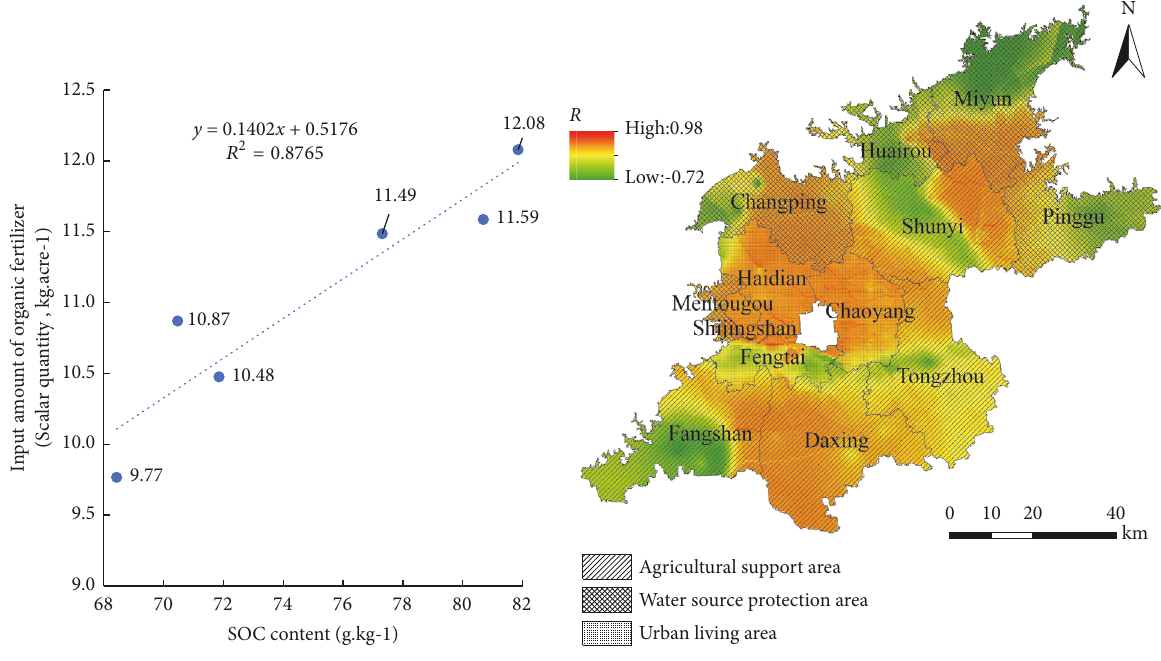
(b) Spatial correlation between soil organic carbon content and input amount of organic fertilizer Figure 4: The relationship between soil organic carbon and the input of organic fertilizer. Values in each row with the same letter are not significant (P > 0.05). In the equation, x and y, respectively, indicated soil organic carbon content and input amount of organic fertilizer. Table 2: The soil organic carbon content of variant soil textures in different